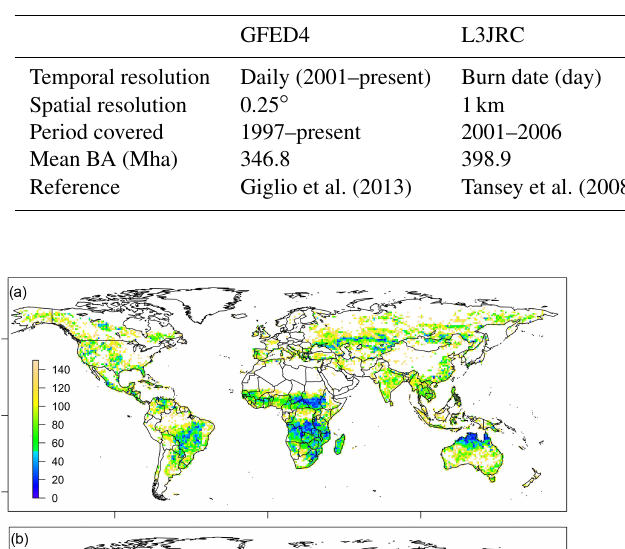
Table 3. Overview of the burnt-area (BA) products used for the intercomparison and their characteristics.